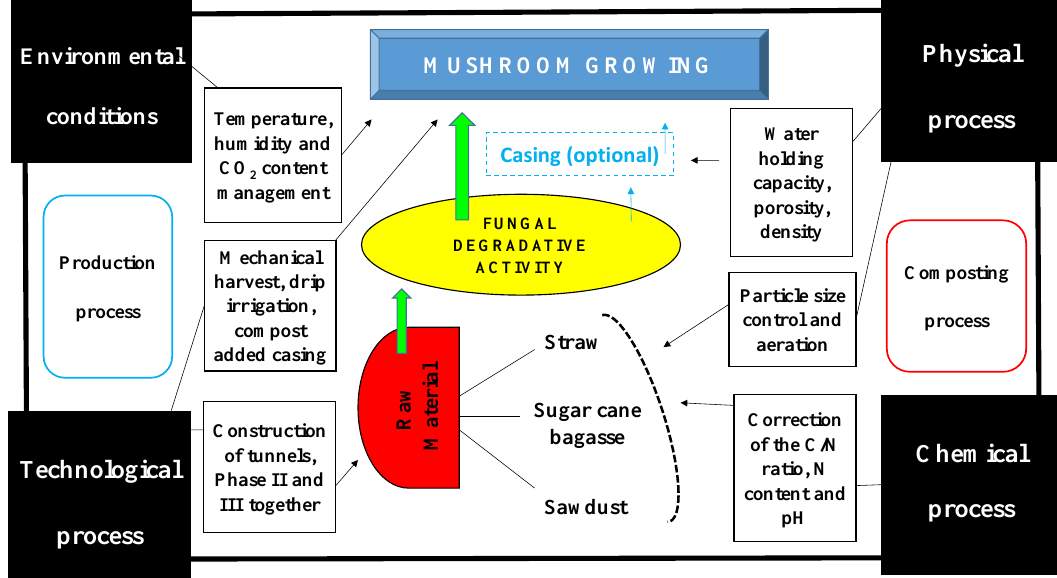
Figure 1. Scheme of mushroom cultivation and the main chemical, physical, environmental and technological process / conditions, which can influence the most important stages of the production.